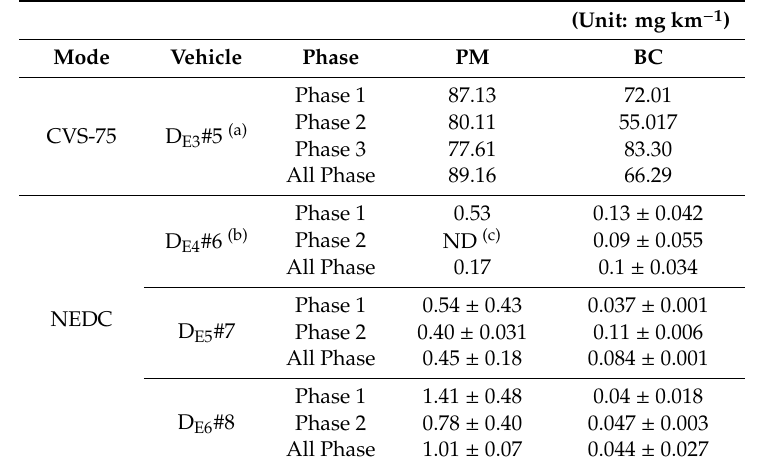
Table 7. Results of PM and BC emission from EURO 3 for CVS-75 mode, and EURO 4, 5, and 6 for NEDC mode.